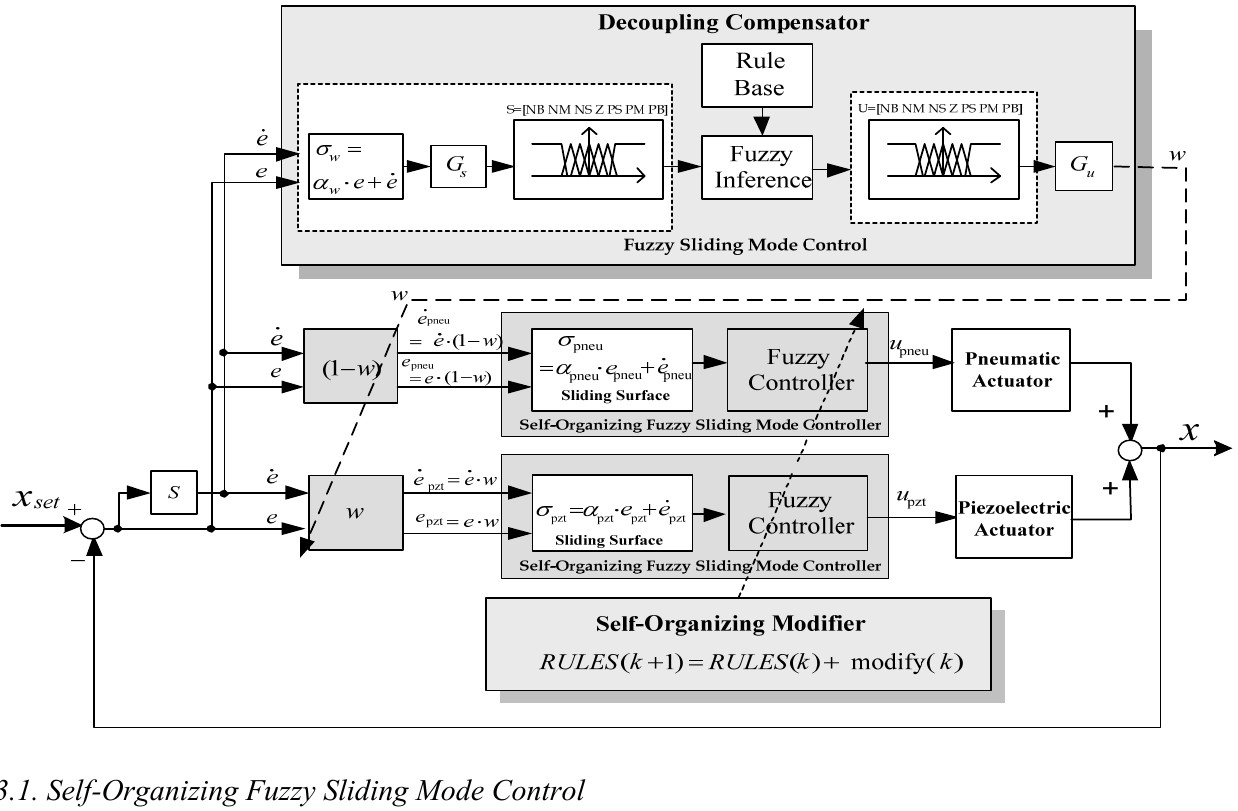
Figure 4. Decoupling self-organizing fuzzy sliding-mode control for single